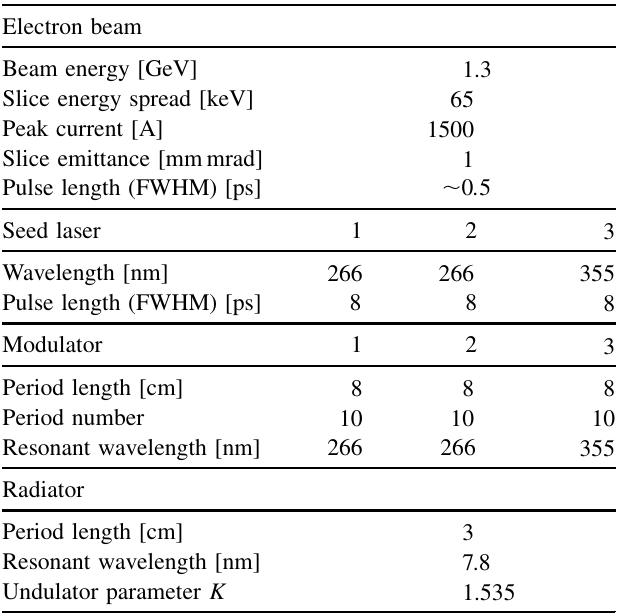
TABLE I. Simulation parameters.